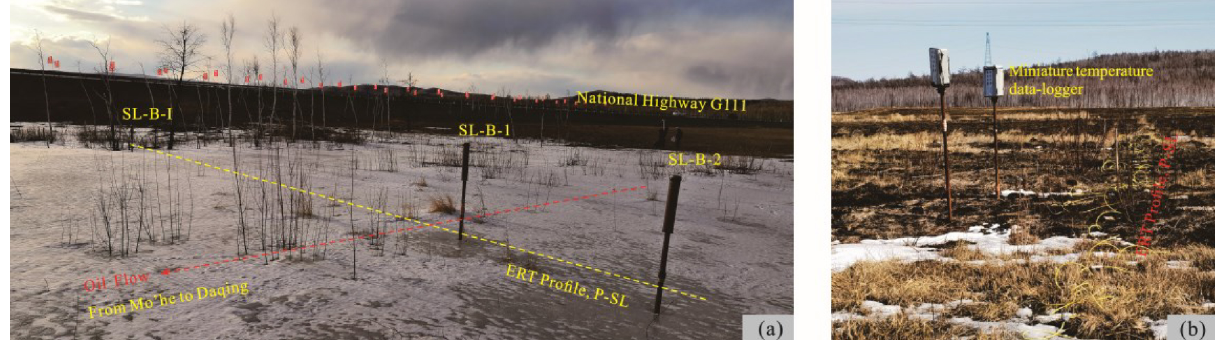
Figure C2. Position of boreholes drilled on and off the pipeline ROW and the ERT profile at the SL permafrost site. Notes: (a) Photo was taken on 30 March 2018. The ground surface within the trench is completely covered with ice and snow. (b) Miniature temperature data loggers were installed in August 2020. Photo was taken on 17 April 2021. The surface vegetation was destroyed by a controlled